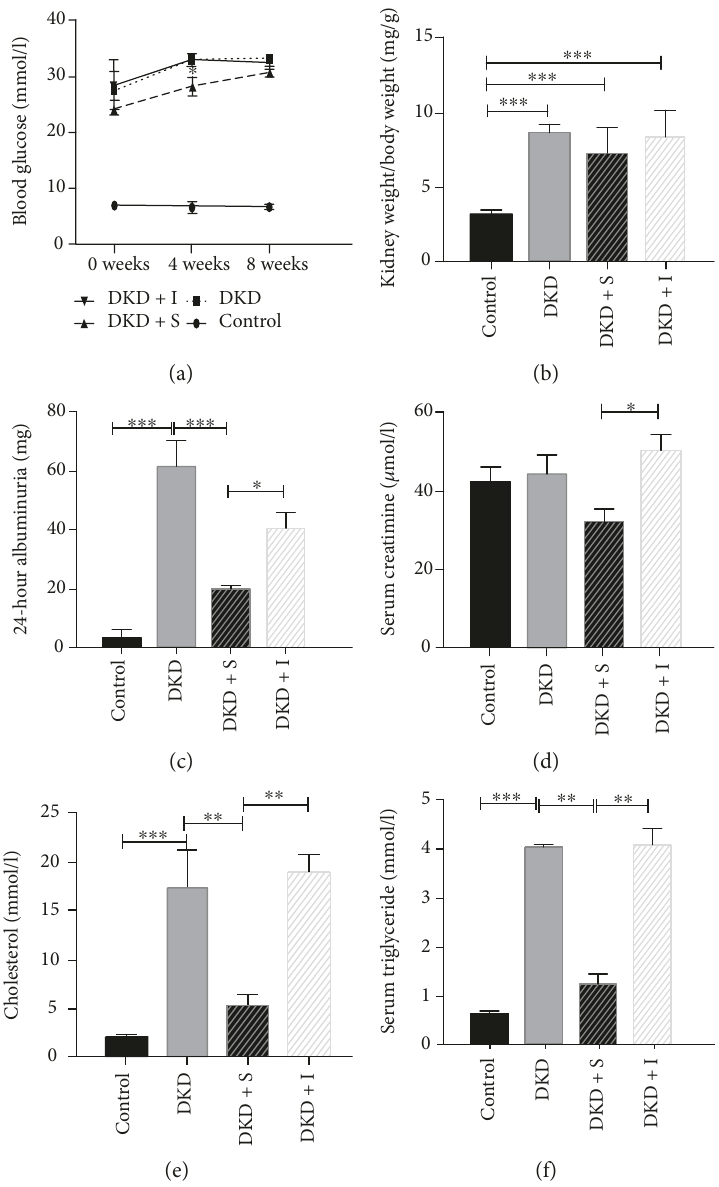
Figure 1: SYFSF attenuated renal injury in DKD rats. (a) Blood glucose was signi fi cantly increased after uninephrectomy, STZ-injection, and high-fat-diet induction. The glucose level in the SYFSF group was lower compared with that in the DKD and irbesartan groups. (b) Compared with the normal rats, the diabetic rats developed signi fi cant emaciation. (c) The 24-hour urinary protein in the DKD group increased markedly which was signi fi cantly suppressed by SYFSF treatment. (d) The levels of serum creatinine between the SYFSF group and the irbesartan group had statistical signi fi cance. (e, f) Serum cholesterol and triglyceride levels obviously increased in the diabetic groups, and SYFSF obviously decreased the levels of cholesterol and triglyceride. DKD+ S represents the DKD rats treated with SYFSF. DKD +I represents the DKD rats treated with irbesartan. ∗ P < 0 05 , ∗∗ P < 0 01 , and ∗∗∗ P < 0 001